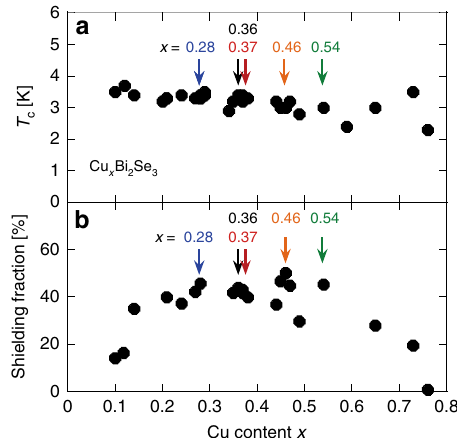
Fig. 2 Properties of the samples. Cu content ( x ) dependence of ( a ) the superconducting critical temperature T c and ( b ) the shielding fraction at 1.8 K. The arrows indicate samples used for the H c2 and NMR measurements reported in this